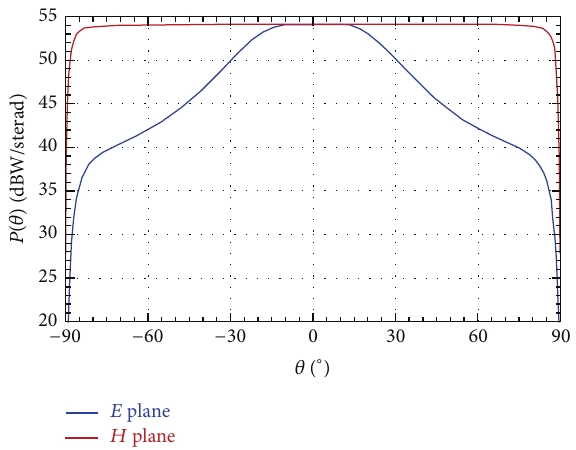
𝐵 𝑓 Figure 6: Radiation patterns in the 𝐸 and 𝐻 planes at 𝑓 = 1 GHz for a structure with 𝑏 = 𝜆 0 /70 and 𝐵 𝑓 = 11.41